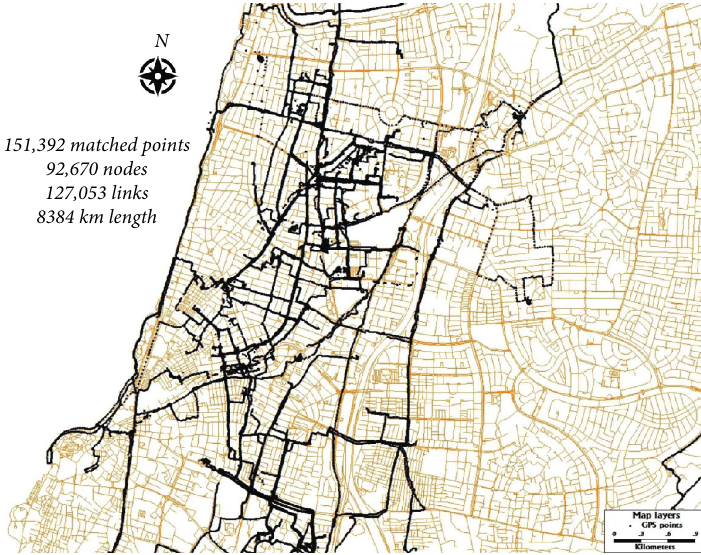
Figure 11: GPS points of bicycle